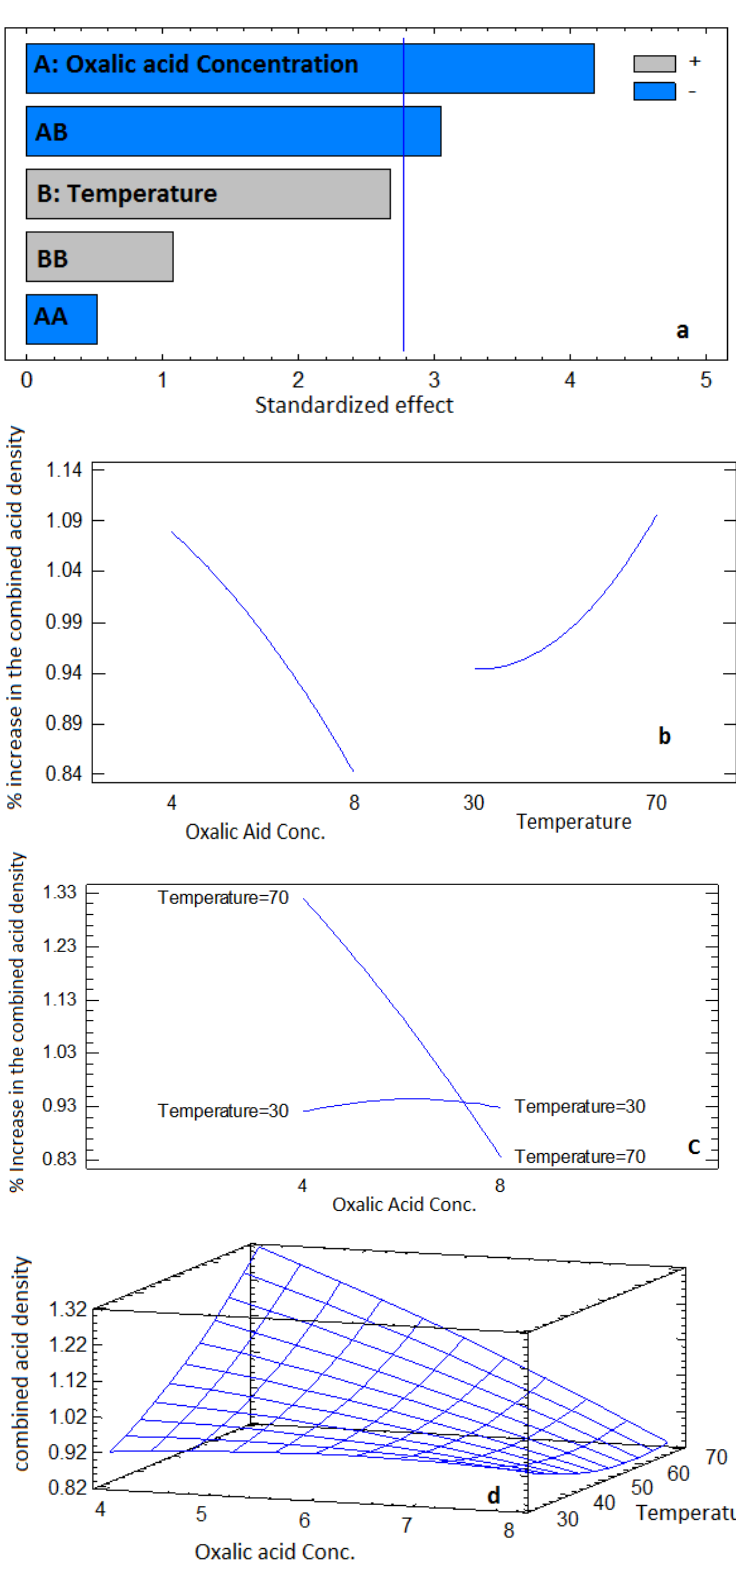
Figure 5. Pareto chart ( a ), standardized effects plot ( b ), interaction plots ( c ), 3D response surface ( d ) for percentage increase in the combined acid density after